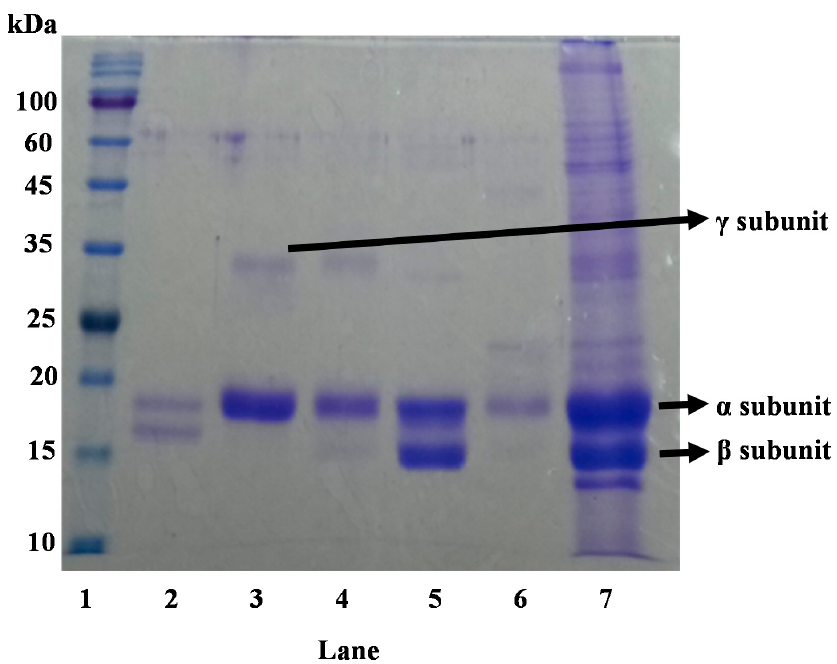
Figure 6. SDS-PAGE chromatogram of phycobiliproteins from Porphyra . Lane 1: Protein marker; Lane 2: C-PC standard; Lane 3: R-PE standard; Lane 4: R-PE fraction; Lane 5: R-PC fraction; Lane 6: small molecular PE fraction; Lane 7: UF > 100 kDa.